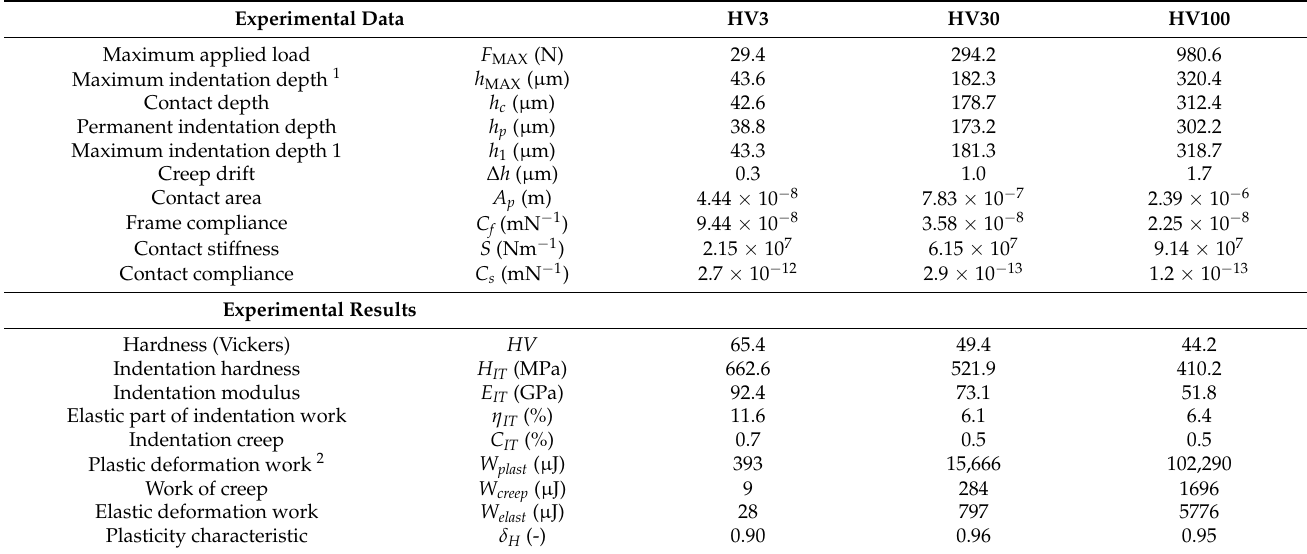
Table 3. Data of the HV test results on copper